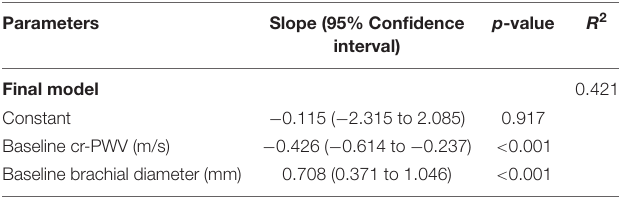
TABLE 5 | Determinants of change in carotid-radial PWV after